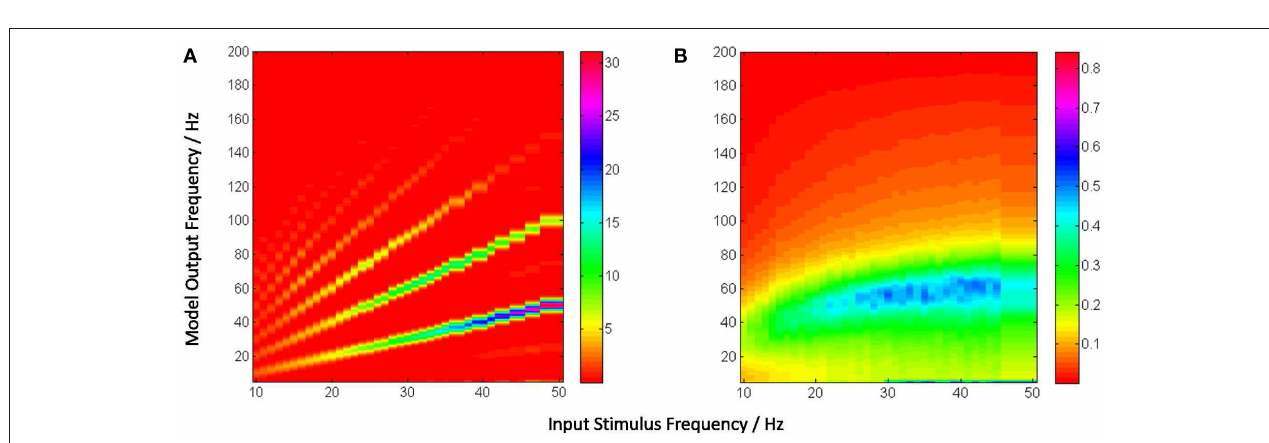
FIGURE 4 | (A) Conceptual block diagram of a Dynamic Vision Sensor (DVS) pixel. (B) Illustration of the spikes generated by a DVS pixel with a sinusoidal illumination. Upper trace represents the pixel illumination versus time. Middle trace represents the positive spikes generated by the pixel along time. Lower trace represents the negative spike timings. (C) Raster plot of the positive spikes generated by 12 × 12 pixels of the electronic retina subjected to a 10 Hz flashing LED during 1 s, and (D) raster plot of the first positive spike generated by the same 12 × 12 pixels of the electronic retina after each illumination positive transition during the same 1 s.